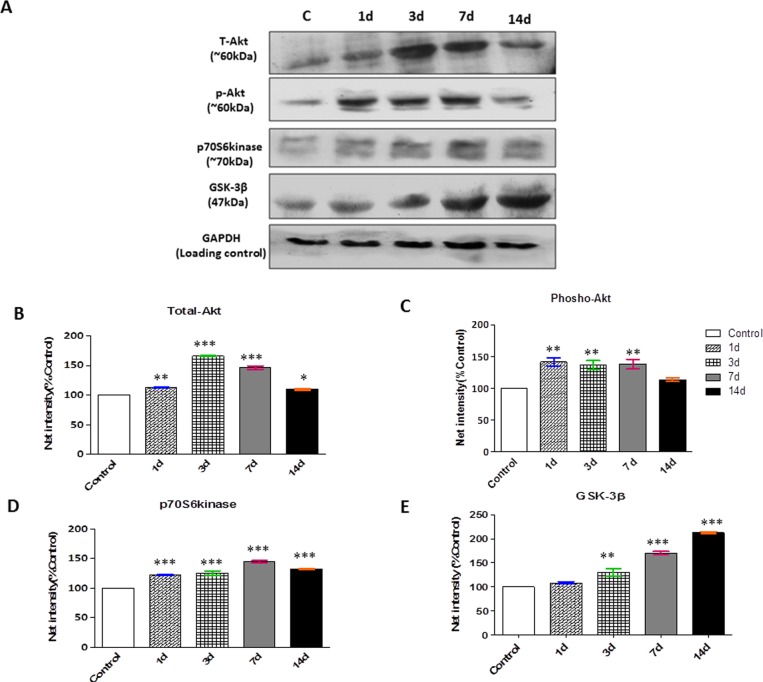
Anabolic signalling / protein translational machinery response under chronic hypoxia insult.(A) Representative western blots for expression of protein synthesis cascade, in skeletal muscles tissues cytoplasmic extracts. GAPDH considered as the loading control and (B-E) Semiquantitative analysis of the expression of total-Akt, p-Akt, p70S6kinase and GSK-3β respectively is presented in the graphs. The densitometric analysis is shown as mean with standard error (bars) performed in n = 3 independent experiments. *p<0.05 Vs. Control; **p<0.01 Vs. Control; ***p<0.001 Vs. Control.